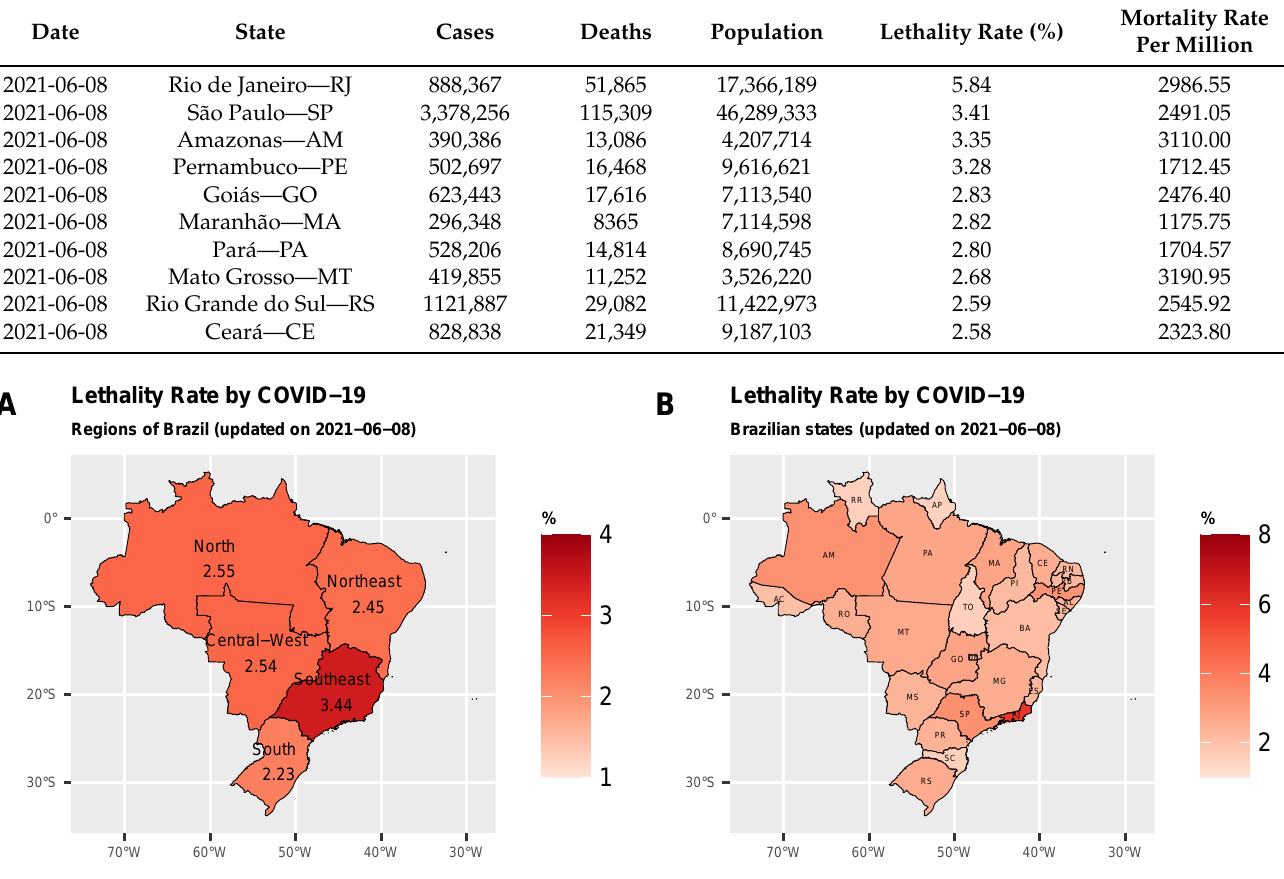
Figure 1. Lethality rate (%) by regions and states in Brazil (S are degrees South and W are degrees West).